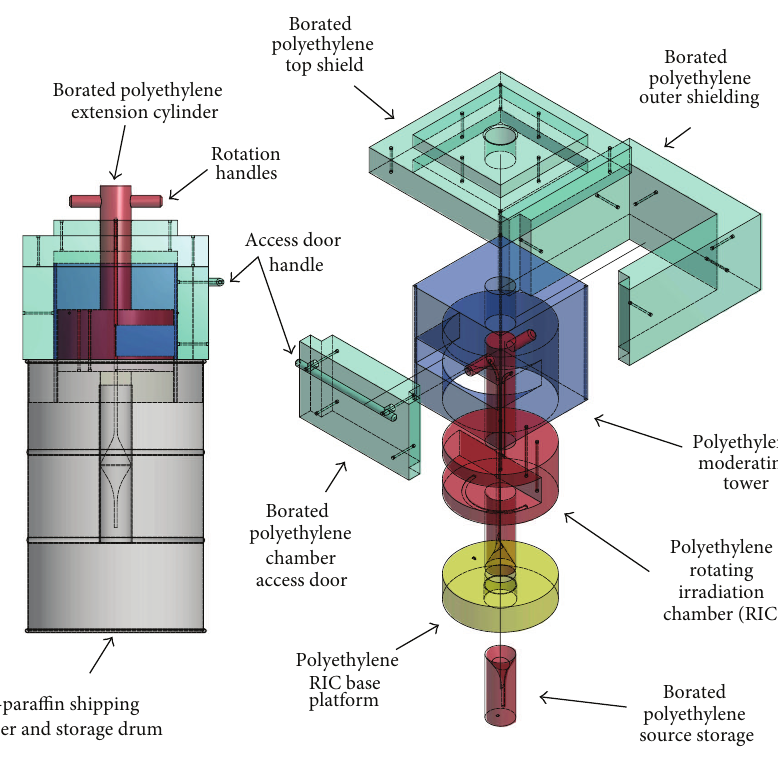
Figure 2: Exploded view irradiator components from computer-aided modeling software.